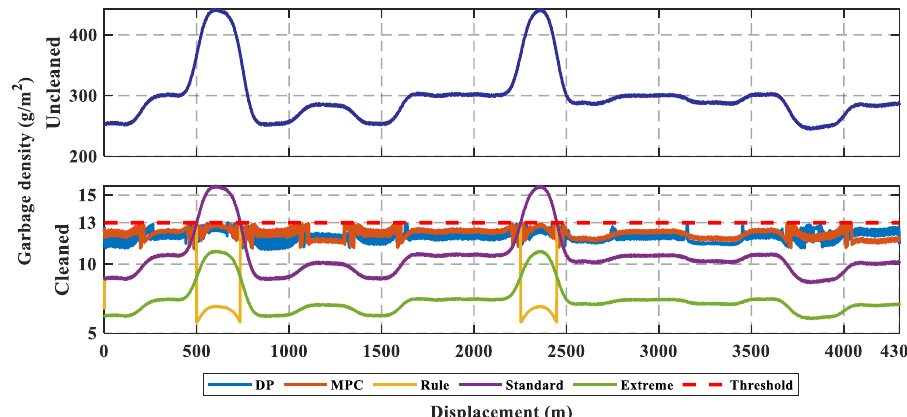
Figure 25. Garbage residues of different EMSs. From the perspective of mission accomplishment, except for the fixed standard mode, Table 5. Main statistical indicators of different strategies. all strategies met the requirement with varying degrees. It is noted that DP and the AMPC took full advantage of the regulation by restricting the residues within a narrow area very close to the threshold. By contrast, the rule-based strategy performed more desirably because of the low average of residues. Besides, there is no doubt that the fixed extreme mode can realize the best cleaning effect regardless of economic energy